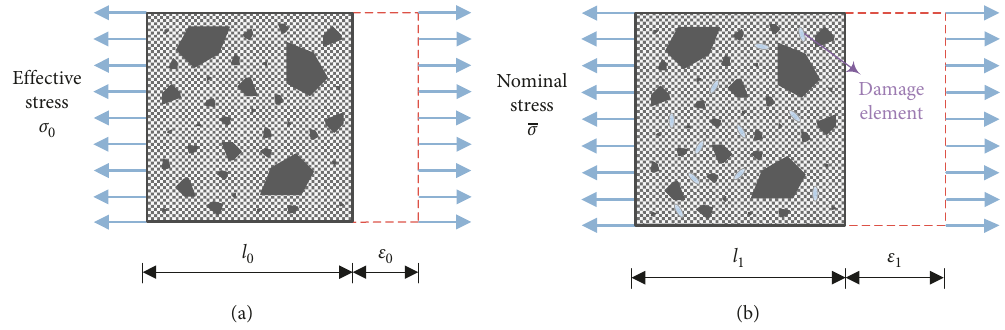
Figure 12: Lemaitre strain equivalence principle. (a) Before destruction. (b) After destruction.